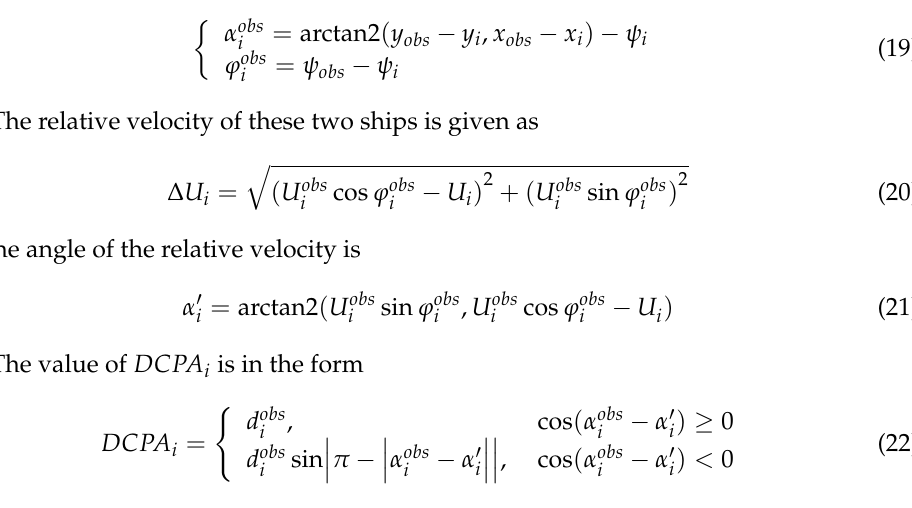
represents the Euclidean distance between U and ψ are the speed and heading angle i i